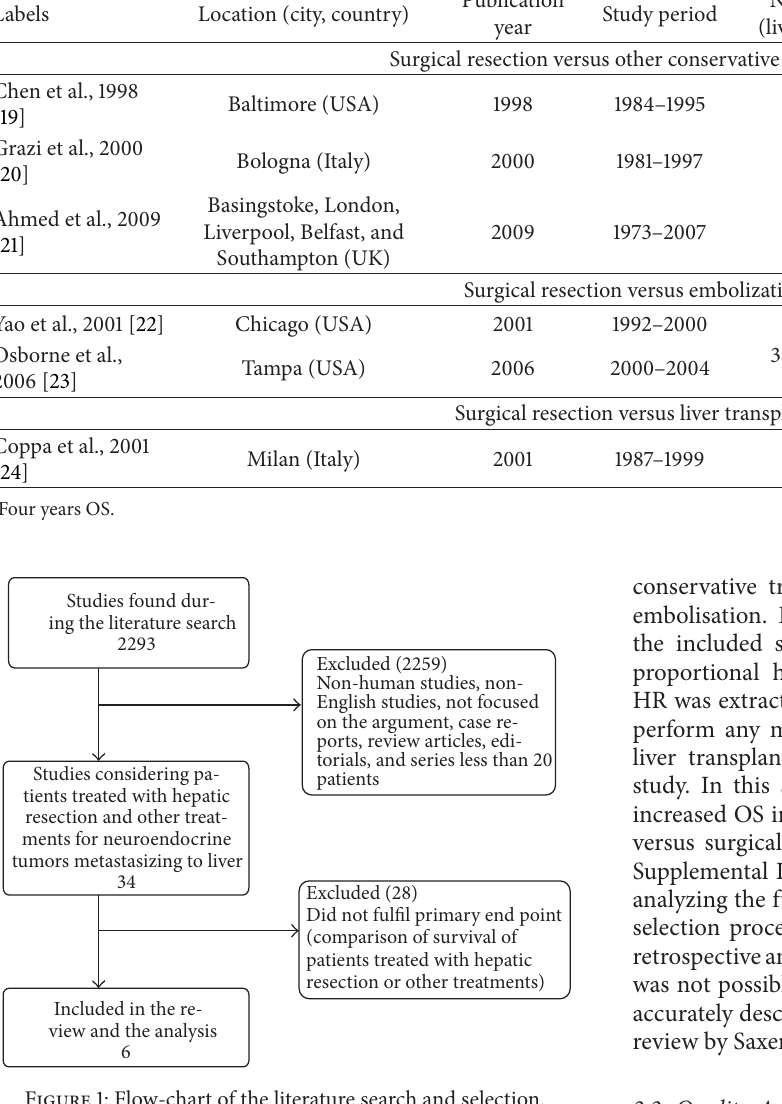
Figure 1: Flow-chart of the literature search and